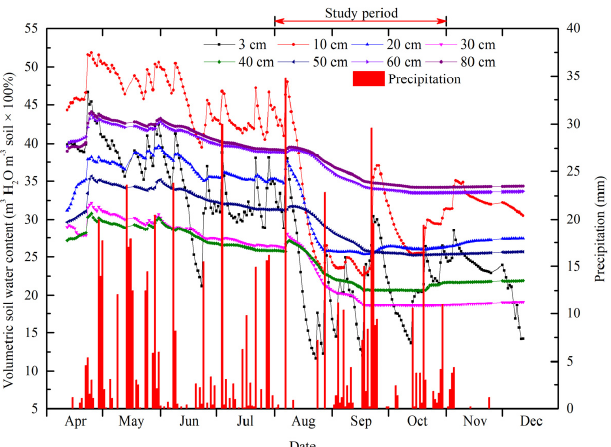
Figure 2. Trends of volumetric soil ‐ water contents (m 3 H 2 O m − 3 soil × 100%) for all measurement depths of soil precipitation throughout the growing season. The period division based on soil ‐ water conditions was obvious. Note that the study period for the present research is marked on top.